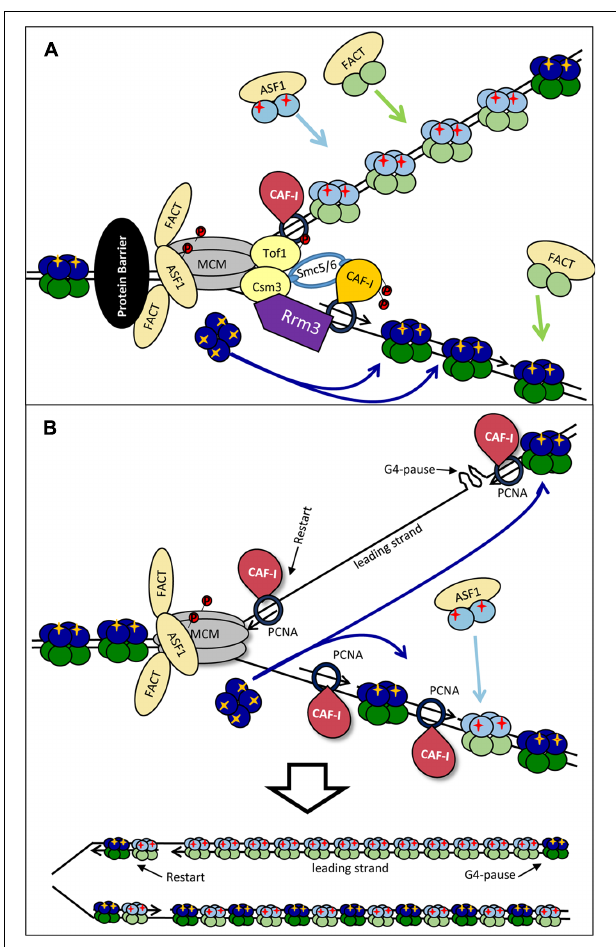
FIGURE 5 | Models for the dissimilar nucleosome assembly on the leading and the lagging strands. (A) Modulation by Rrm3p. Rrm3p (purple) associates with PCNA on the lagging strand to displace a tightly bound protein (shown by a black oval). This Rrm3p–PCNA interaction alters the association of CAF-I (depicted by orange color) and precludes its activity on the lagging strand only. Consequently, the lagging strand intercepts “old” H3/H4 tetramers, but the assembly of new H3/H4 is inhibited. It is possible that the disproportional incorporation of “old” H3/H4 on the lagging strand promotes the deposition of newly synthesized histones on the leading strand. (B) By-passing of the impediment. A G4-DNA has arrested the DNA polymerase on the leading strand. DNA synthesis has restarted downstream of the impediment. The G4 structure is then relieved by a specialized helicase and the gap is filled in by a later stage DNA synthesis. However, this later-stage DNA synthesis takes place away from the source of “old” H3/H4 histones (dark blue) and nucleosomes are assembled with “new” histones (light blue) only. For details see Sarkies and Sale (2012b).